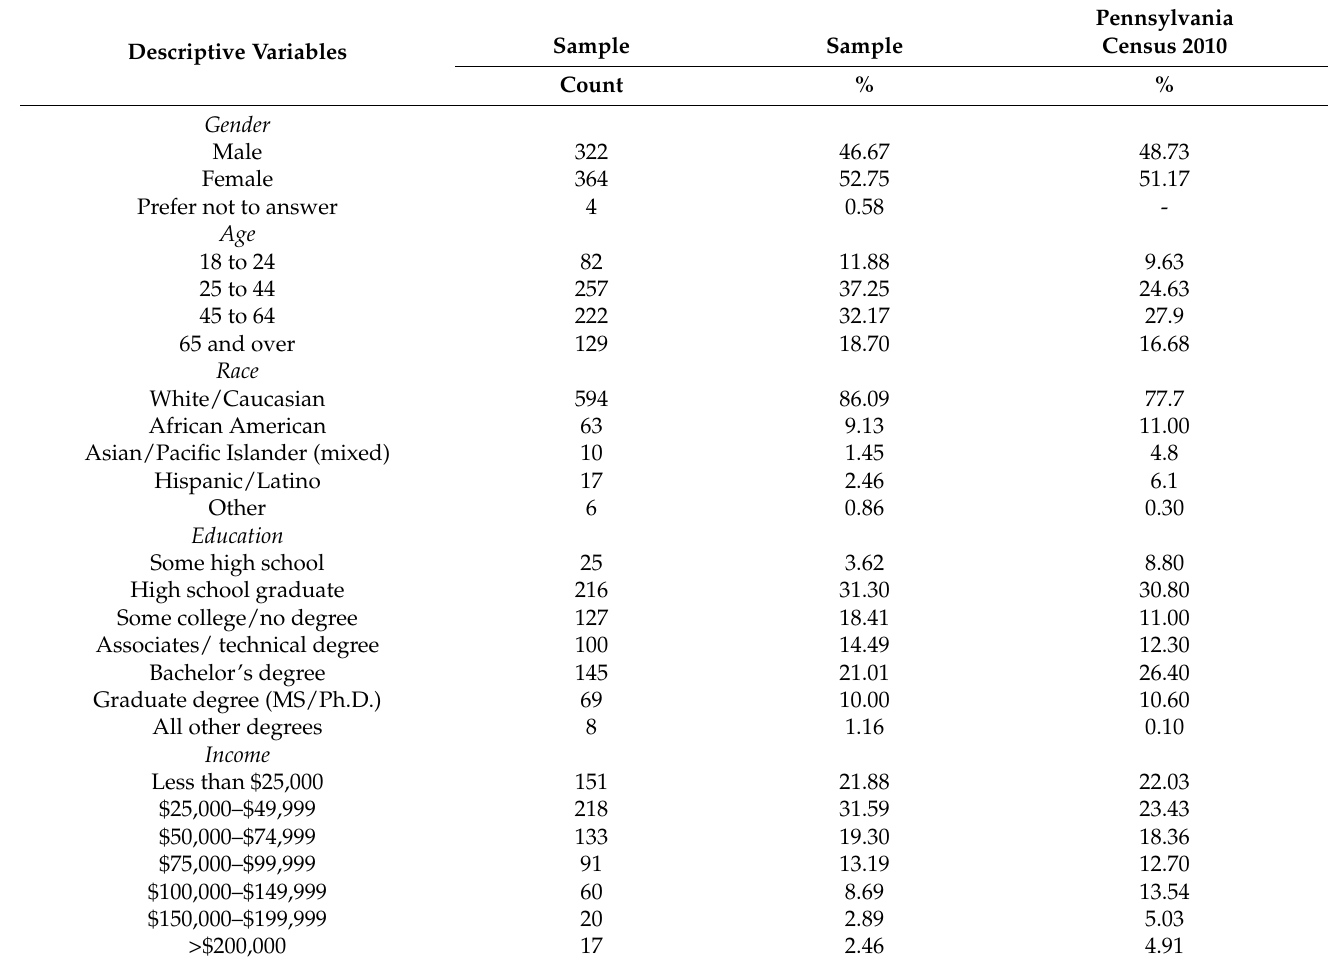
Table 4. Table showing respondent’s characteristics in